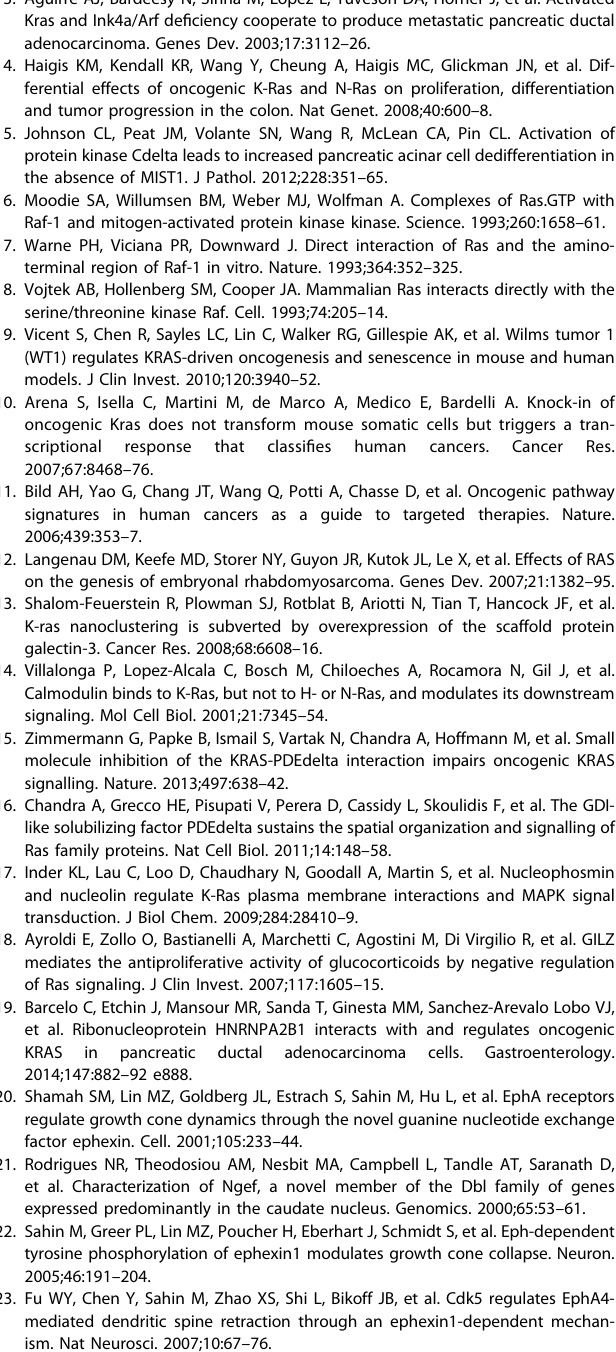
Fig. 6 Ephexin1 is phosphorylated at Ser16/18 in human CRC and LC tissues and is associated with poor prognoses. A Representative image of pSer16/18 Ephexin1 immunoreactivity in normal and cancerous colorectal and lung tissues (separated by dashed lines). B , C IHC staining was performed to evaluate pSer16/18 Ephexin1 expression in normal, grade I/II, grade III/IV, and metastatic CRC ( B ) and LC ( C ) tissues and their corresponding normal tissues. Hematoxylin is the counterstain. Scale bar = 100 μ m. Expression scores of pSer16/18 Ephexin1 in CRC tissue microarray (TMA) that was containing 9 cases of normal mucosa tissues, 14 cases grade I/II, 26 cases grade III/IV, and 10 cases of metastatic tumor tissues. Expression scores of pSer16/18 Ephexin1 in LC TMA that was containing 9 cases of normal mucosa tissues, 27 cases grade I/II, 13 cases grade III/IV, and 10 cases of metastatic tumor tissues. Data are shown as mean ± SD, P values are for a Mann – Whitney test. D A Kaplan – Meier graph representing overall survival rates for patients with pSer16/18 Ephexin1-overexpressing CRC. High pSer16/18 Ephexin1 expression, n = 33; low pSer16/18 Ephexin1 expression, n = 12. P values are for a log-rank test. E As in ( D ) but for LC. High pSer16/18 Ephexin1 expression, n = 42; low pSer16/18 Ephexin1 expression, n = 8. P values are for a log-rank test. F Schematic representation of a model for the major mechanism of the tumorigenic effect of Akt-mediated Ephexin1 phosphorylation on CRC and